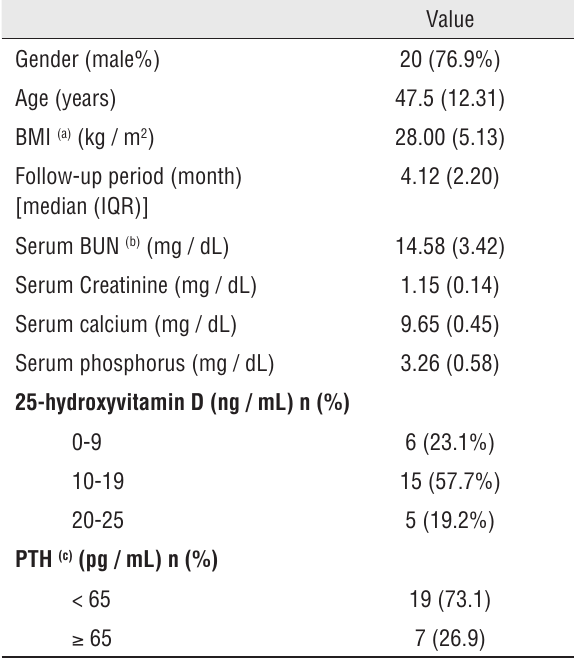
Table 1 - Baseline characteristics of recurrent calcium stone patients with vitamin D deficiency. All values are mean (SD) unless otherwise